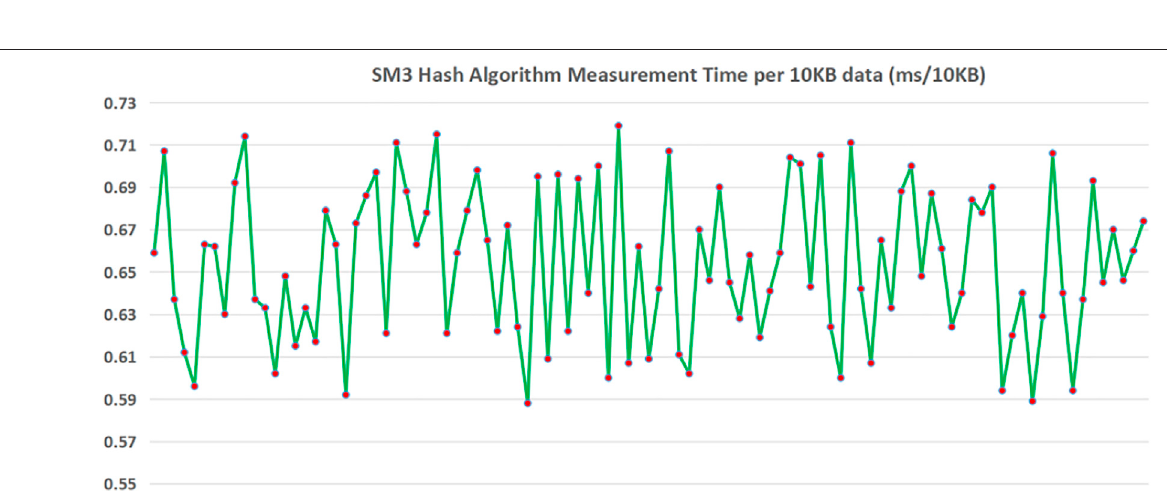
Frontiers in Energy Research |